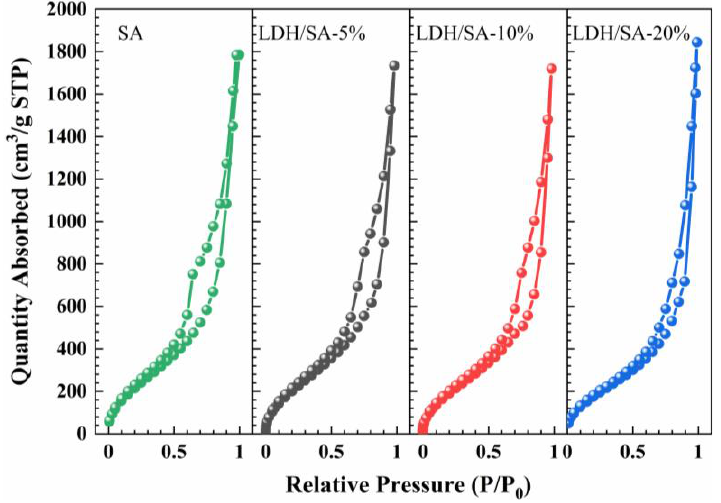
Figure 5. N 2 adsorption – desorption isotherms of SA and LDH/SA composites.